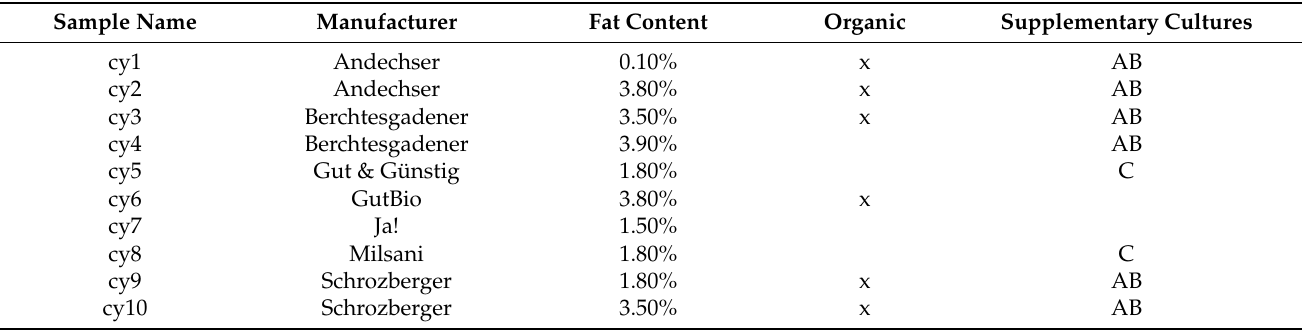
Table A3. Commercial yogurt (cy) samples were purchased in local food stores in Germany. The manufacturer, fat content, and organic certification, as well as the supplementation with L.